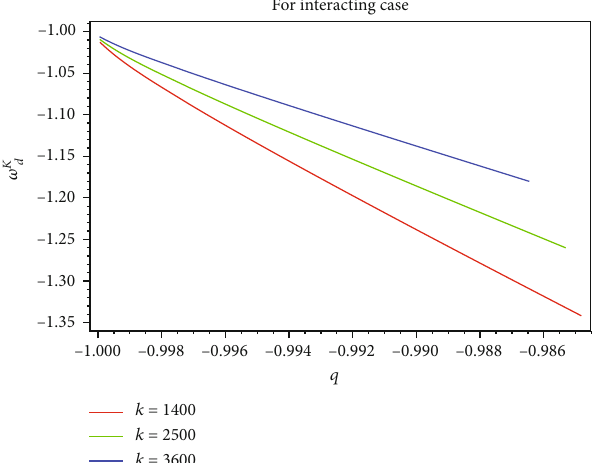
Figure 3: Graph of EoS ω K